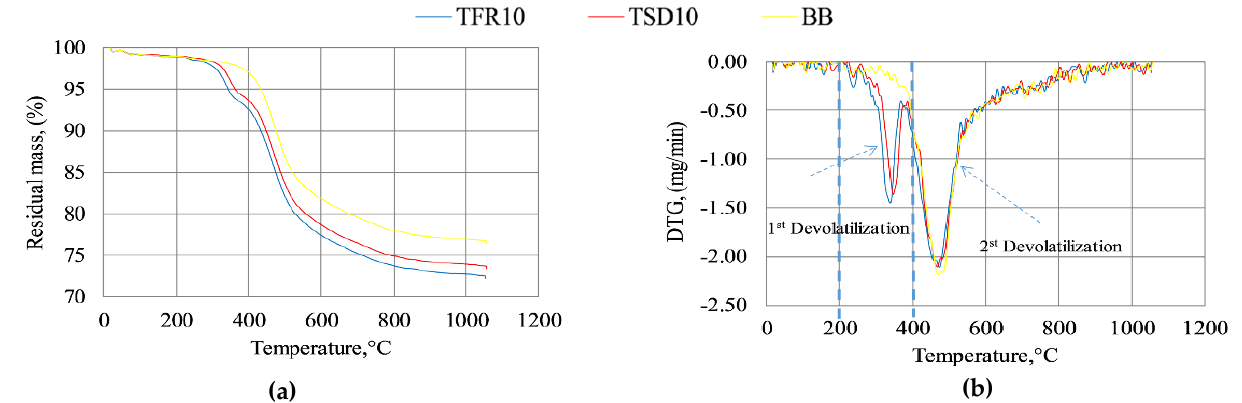
Figure 6. ( a ) TGA ( b ) DTG for TFR10, TSD10, and BB at carbonization conditions in N 2 atmosphere.